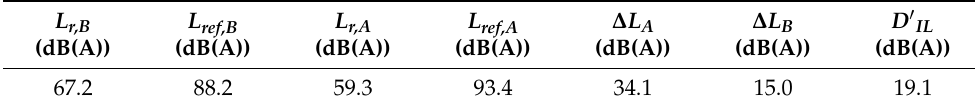
Table 4. Measurement results by the indirect method.